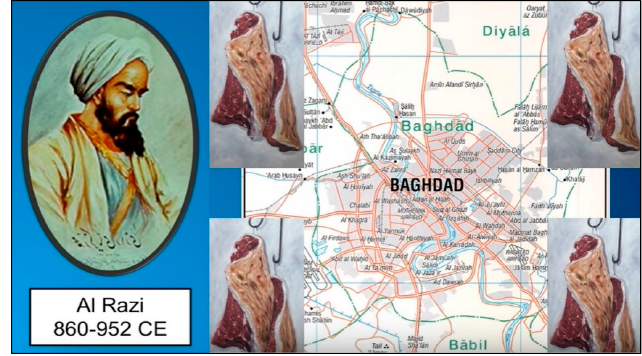
Figure 2. Al-Razi and the best location for building a hospital in Baghdad City (Source: [1]).